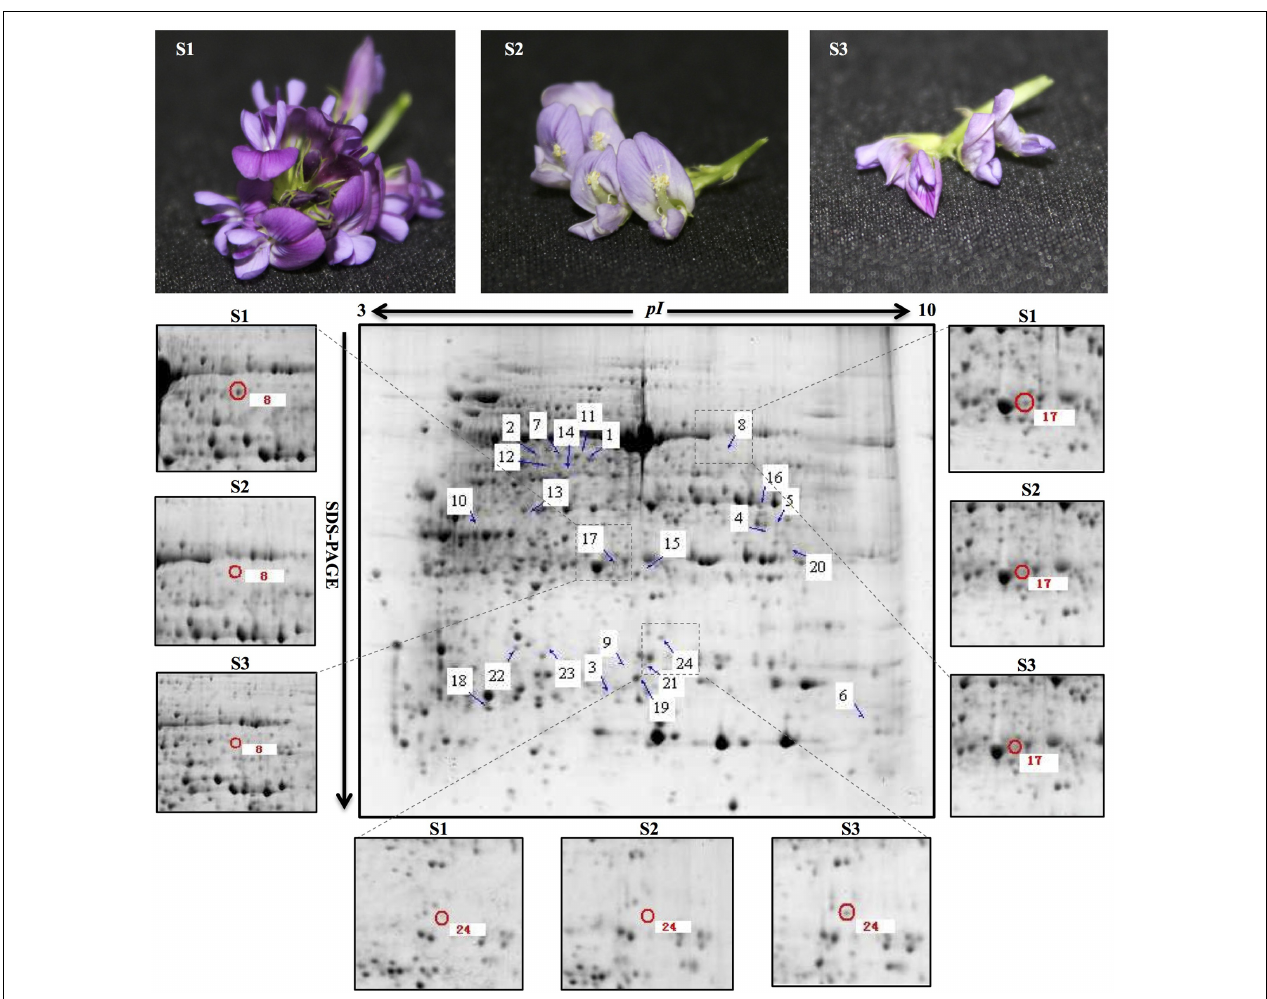
FIGURE 1 | Representative 2-DE pattern of total protein fraction from developing alfalfa flowers. S1: pre-pollinated stage (fully opened with the keels still closed); S2: pollinated stage (2 h after pollination); S3: post-pollination senesced stage (24 h after pollination). Arrows indicate protein spots that were increased or decreased in abundance. Zoomed images show the main differentially expressed protein spots in developing alfalfa flowers. Spot 8 and 17: down-regulation in S2 and S3; spot 24: up-regulation in S3. The three biological replicates of the 2-DE gels are shown in Supplementary Figure